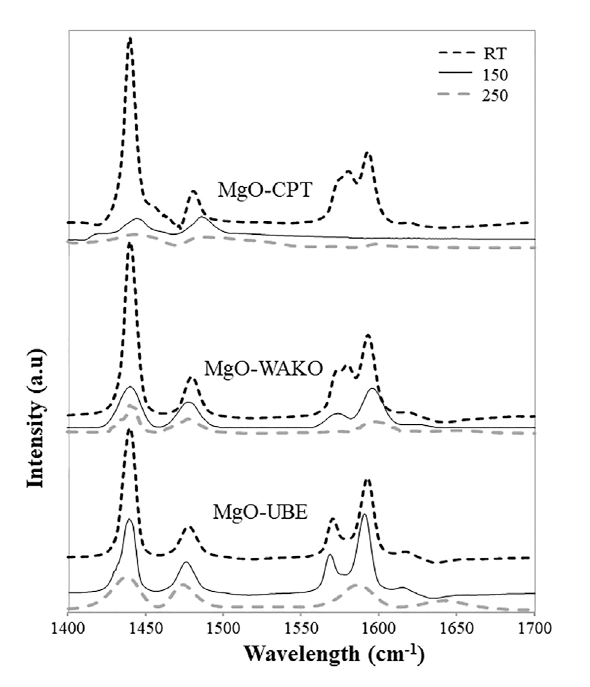
FIGURE 9 Pyridine adsorbed drift spectra of different MgO